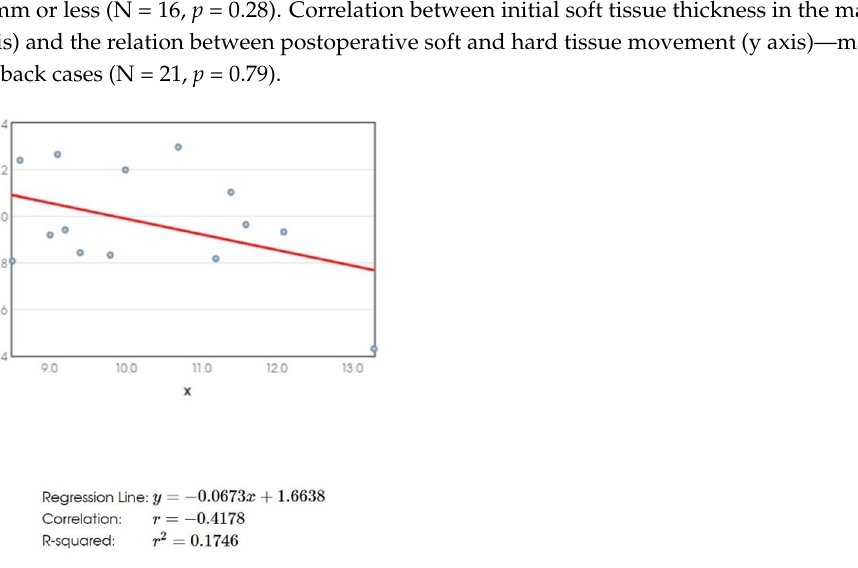
Figure 5. Correlation between initial soft tissue thickness in the mandible (x axis) and the relation between postoperative soft and hard tissue movement (y axis)—mandibular advancement cases (N = 14, p = 0.12).